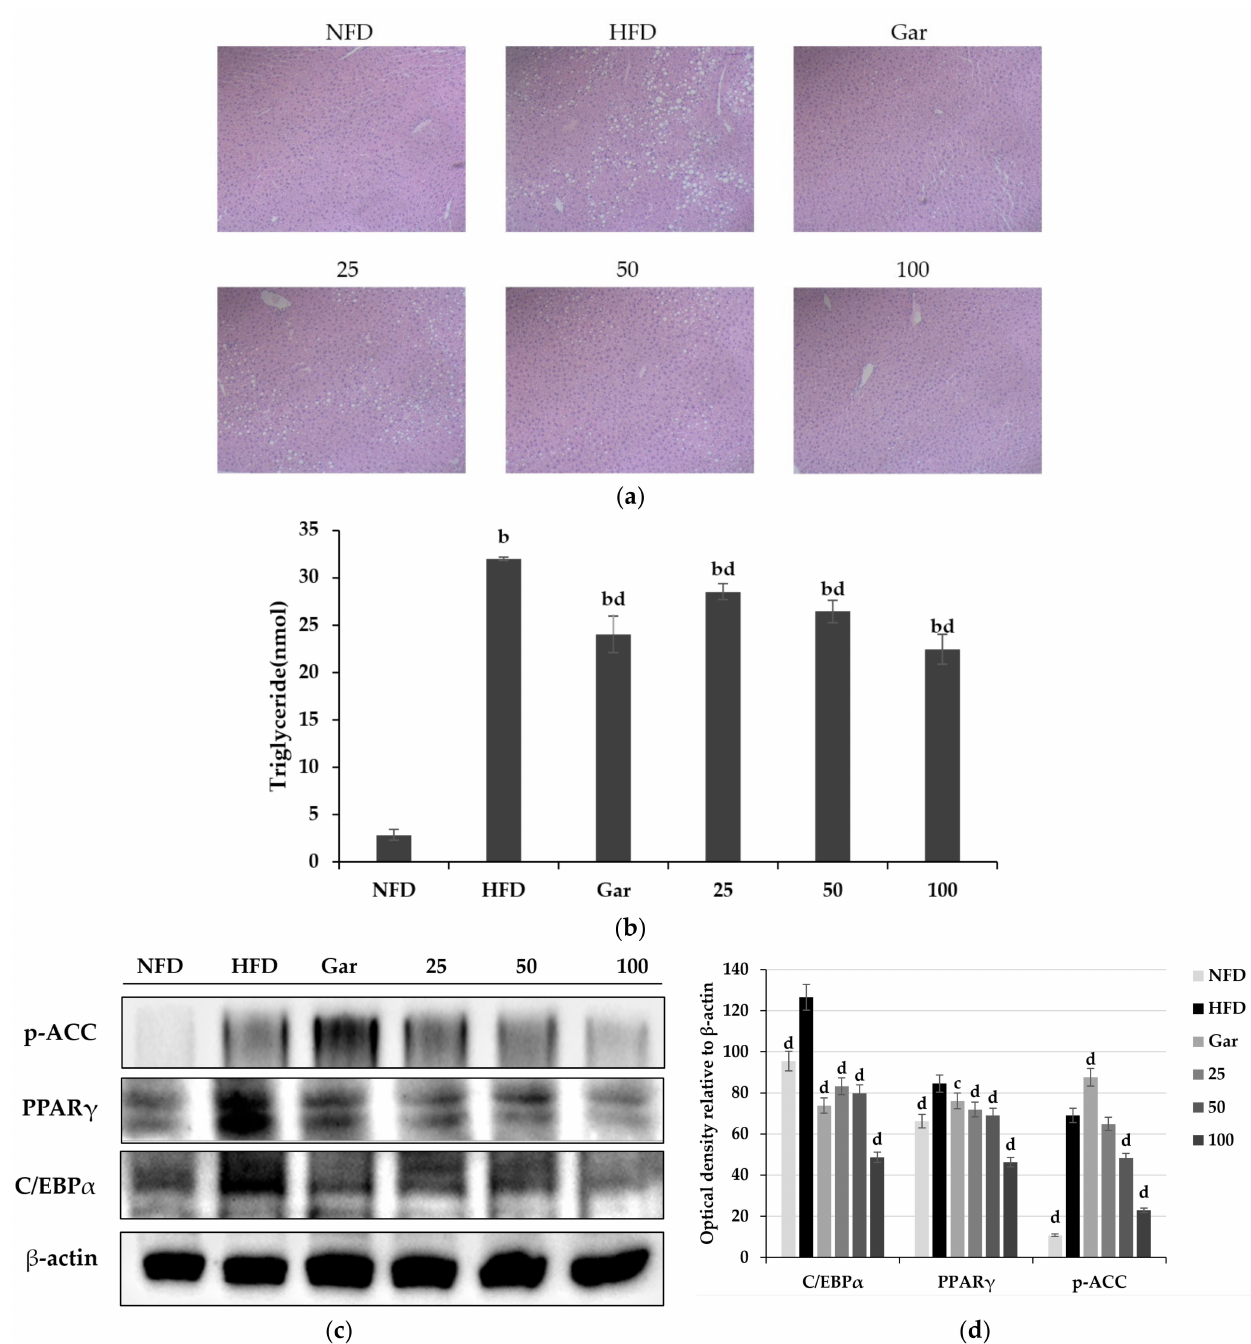
Figure 8. Improvement effect of hot-water barley sprout extract (BSE) on fatty liver. ( a ) Histological changes in liver tissue through H&E staining (400 × , Axiovert100, Oberkochen, Germany). ( b ) Measurement of triglyceride content in liver tissue. Changes in p-ACC, PPAR γ , and C/EBP α expression in liver tissue. Values are the mean ± SD of six mice per group. ( c ) Western blotting and ( d ) semi-quantitative analysis. Statistical analysis was performed using a t -test. b p < 0.01 compared with NFD group. c p < 0.05 and d p < 0.01 compared with HFD group; NFD: normal-fat diet; HFD: high-fat diet; Gar: Garcinia cambogia at 100 mg/kg/day; 25: BSE 25 mg/kg/day; 50: BSE 50 mg/kg/day; 100: BSE 100